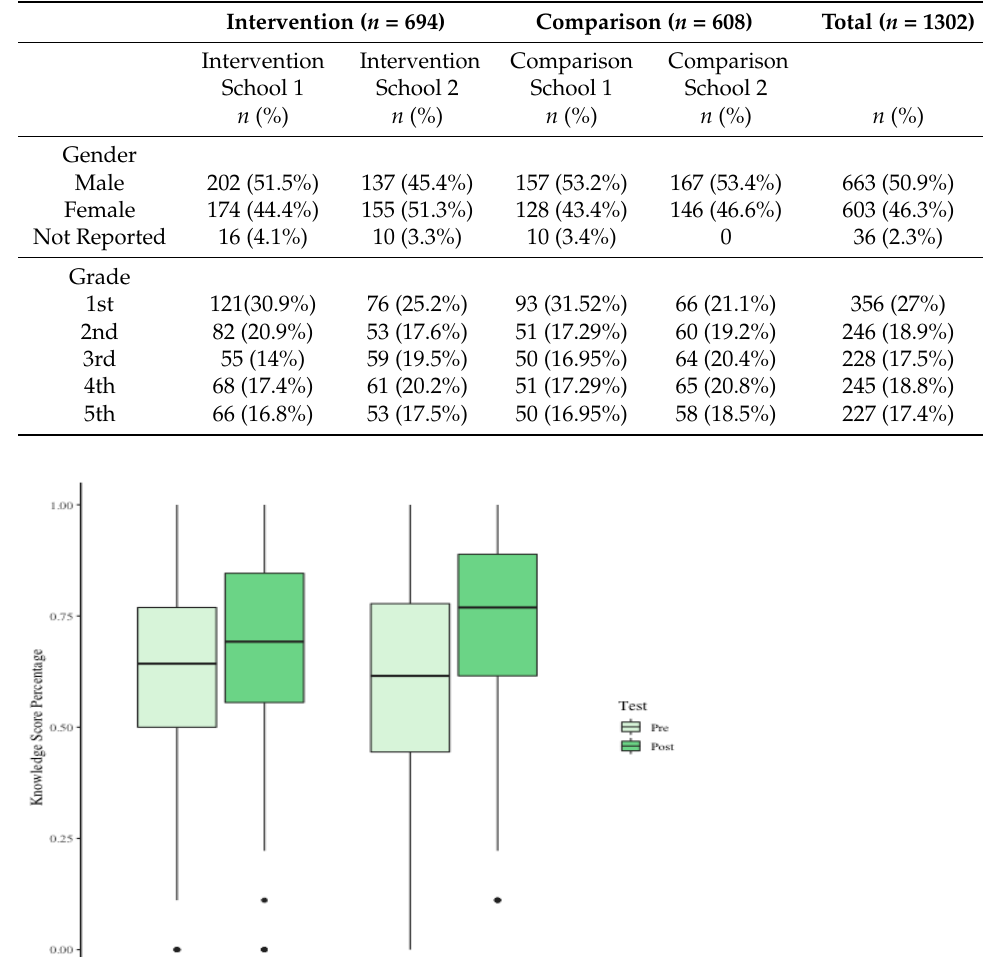
Table 2. Student demographics: baseline assessment ( N = 1302).